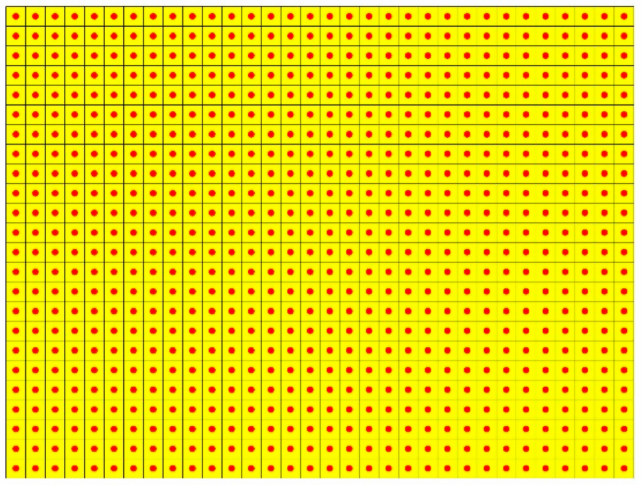
Figure 14. Actual positions of strain measurement points and the inverse elements drawn on the laminate